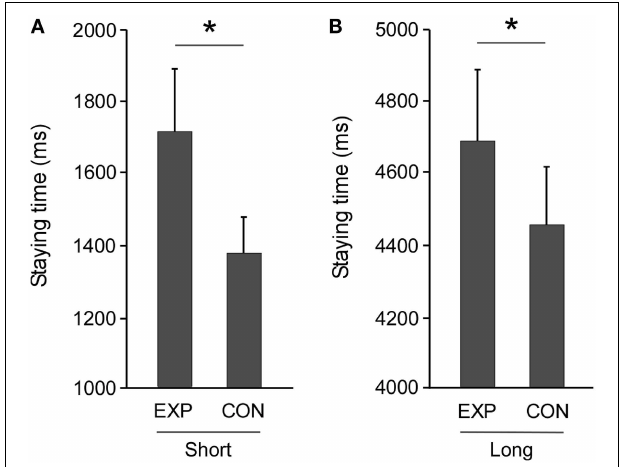
FIGURE 3 | Extension of staying time in an indeterminate situation for another’s action. A t -test showed that mean staying time in the experimental task (EXP) was significantly longer than that in the control task (CON) under (A) Short (20cm in length) and (B) Long (200cm in length) distance conditions ( * p < 0 . 0001 , respectively). Error bars indicate the standard errors of the mean.